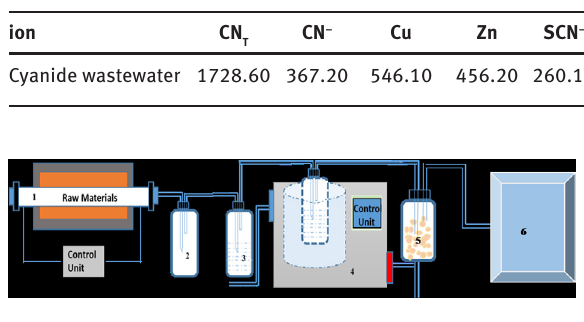
Figure 1: Schematic diagram of the